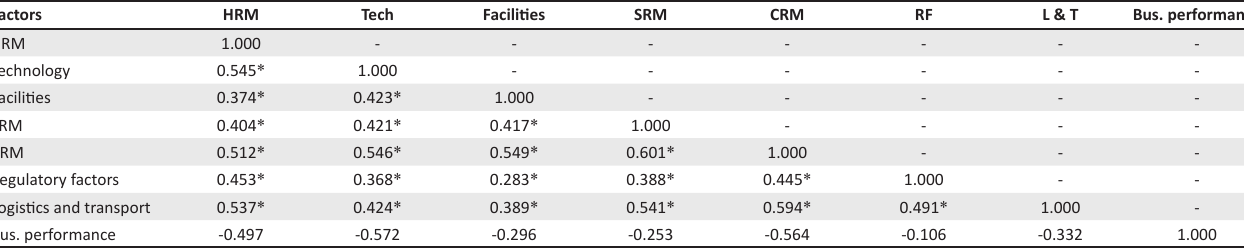
TABLE 2: Correlations: Supply chain management problems and business performance. Factors